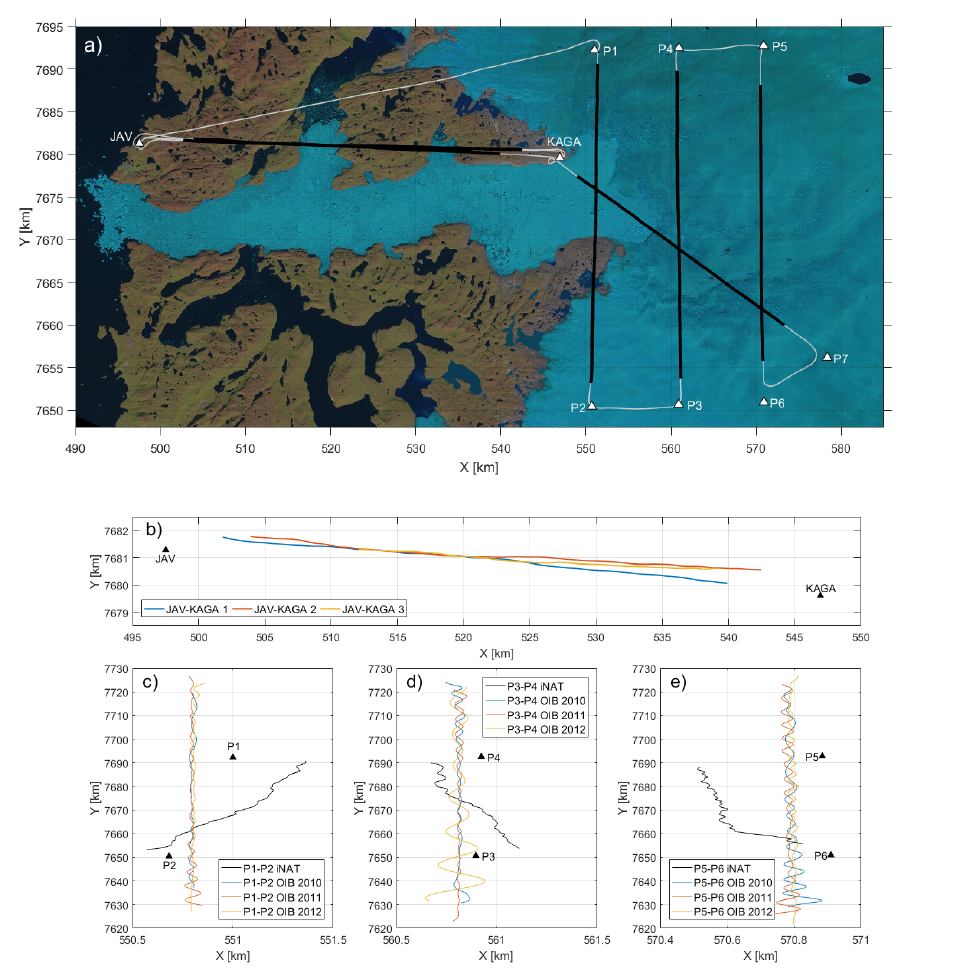
Figure 2. Survey overview: ( a ) ground track of the entire survey (white) along with line profiles (black) on top of Landsat-8 image from 9 August 2016; ( b ) ground track of the three repeat lines between Ilulissat Airport (JAV) and Kangia North GPS station (KAGA); ( c ) ground track of the profiles between P1 and P2; ( d ) ground track of the profiles between P3 and P4; ( e ) ground track of the profiles between P5 and P6. Coordinates are with respect to UTM zone 22. Notice the difference in scale between the x - and y